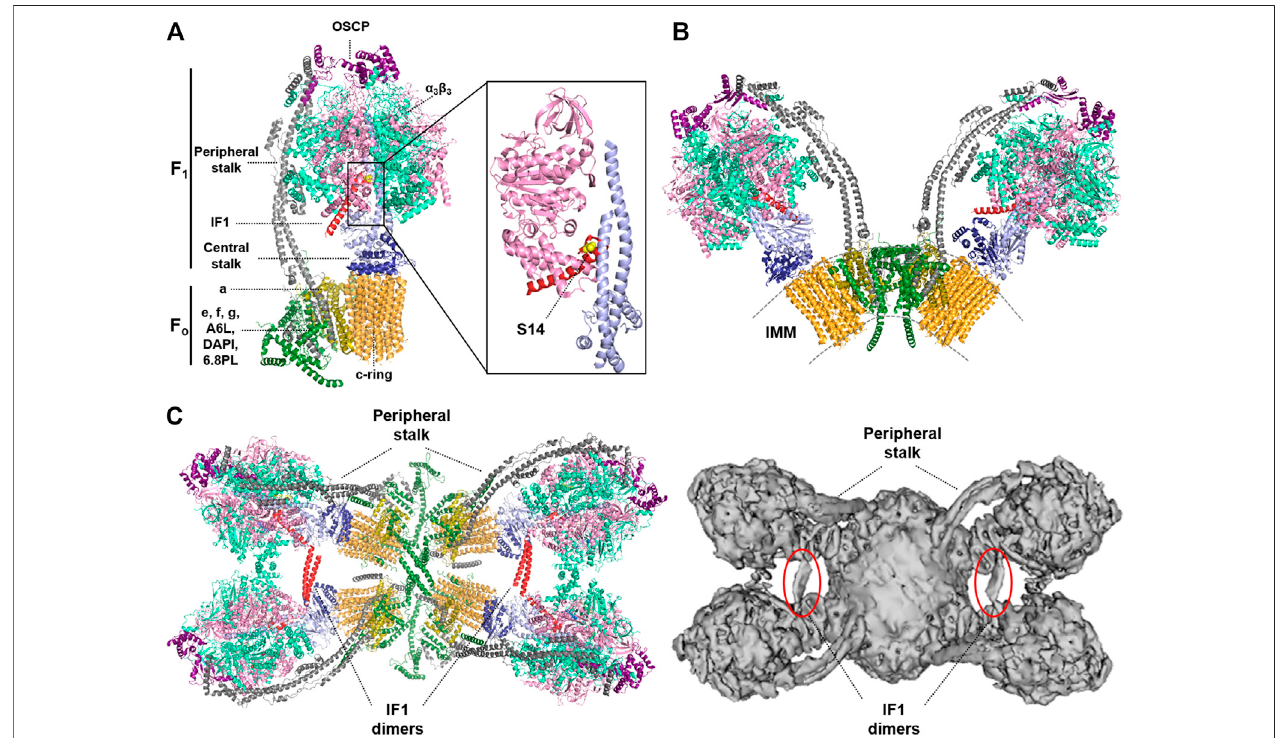
FIGURE 1 | Structure of the monomer, dimer and tetramer of the mammalian ATP synthase. (A) Structure of monomeric bovine ATP synthase bound to the inhibitory N-terminal fragment of IF1. The soluble F 1 -ATPase domain is composed by the α 3 β 3 subassembly (light green/pink) and the central stalk ( γ subunit, light blue, and δ , ε subunits, dark blue), while the F o domain is formed by a ring of 8c subunits (orange), and subunit a (dark yellow). These two domains are linked by a peripheral stalk, made up of subunits b, d, F6 (grey) and oligomycin sensitivity-conferring protein (OSCP; purple). Additional supernumerary subunits have been described in theF o domain;e,f,g,A6L,diabetes-associatedproteinininsulin-sensitivetissues(DAPIT)andthe6.8-kDaproteolipid(6.8PL)(darkgreen).Inset,theinteractionbetween theN-terminalinhibitoryfragmentofIF1(red)andsubunits β (pink)and γ (lightblue)isshown.ThepositionofS14inthehumanandmouseinhibitorypeptideishighlighted inyellow.TheAla14(Ser14inhumanandmouseIF1)isshowninyellow.MolecularreconstructionfromPDB:6ZPO. (B) StructureofthebovineATPsynthasedimer.The supernumerary subunits of the enzyme (DAPIT, e, f, g, A6L and 6.8PL) are involved in the dimerization of the enzyme. IMM, inner mitochondrial membrane. Molecular reconstructionfromPDB:7AJD. (C) Cryo-EMstructuresofporcine(left)andovine(right)ATPsynthasetetramersviewedfromthematrixside.IF1dimers(redorcircledin red) bind two adjacent dimers of the ATP synthase promoting the formation of tetrameric or higher-order oligomers. Molecular reconstruction from PDB: 6J5K (left) and EMD-0667 (right). Images created with the PyMOL Molecular Graphics